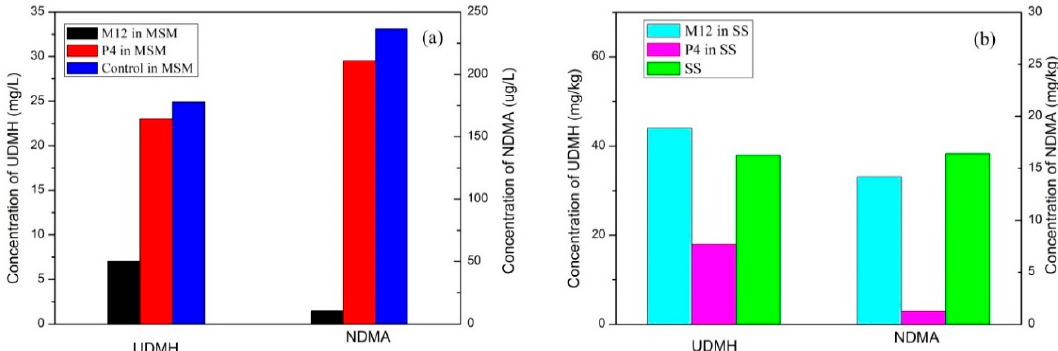
Figure 4. The final concentrations of UDMH and N ‐ nitrosodimethylamine (NDMA) ( a ) in aqueous MSM and ( b ) in SS.